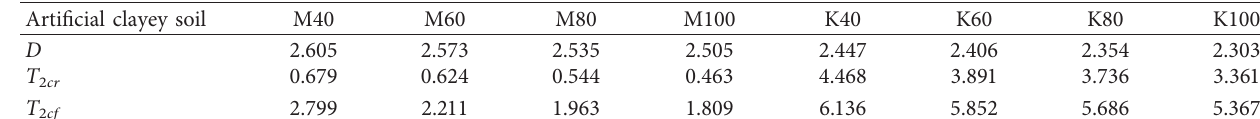
Figure 10: The R 2 , MAE, and RMSE values of the improved and typical TC models. Table 5: The D , T 2 cr , and T 2 cf values of the eight artificial clayey soils.